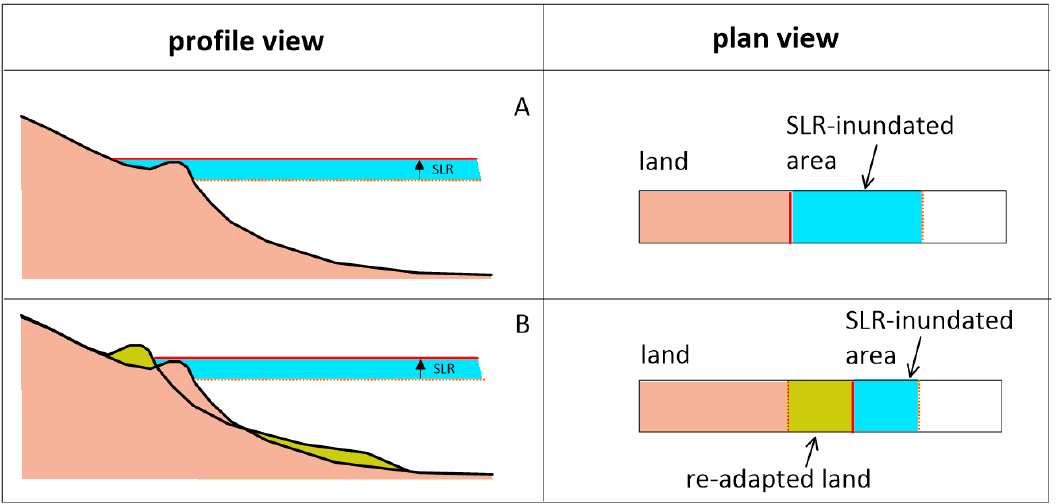
Figure 3. Model of SLR-induced inundation. ( A ) Static-approach and passive inundation following the bathtub method. ( B ) Pseudo-dynamic equilibrium profile response following the Bruun Rule and inundation following a modified bathtub method. Note: the beach profiles are not to scale.